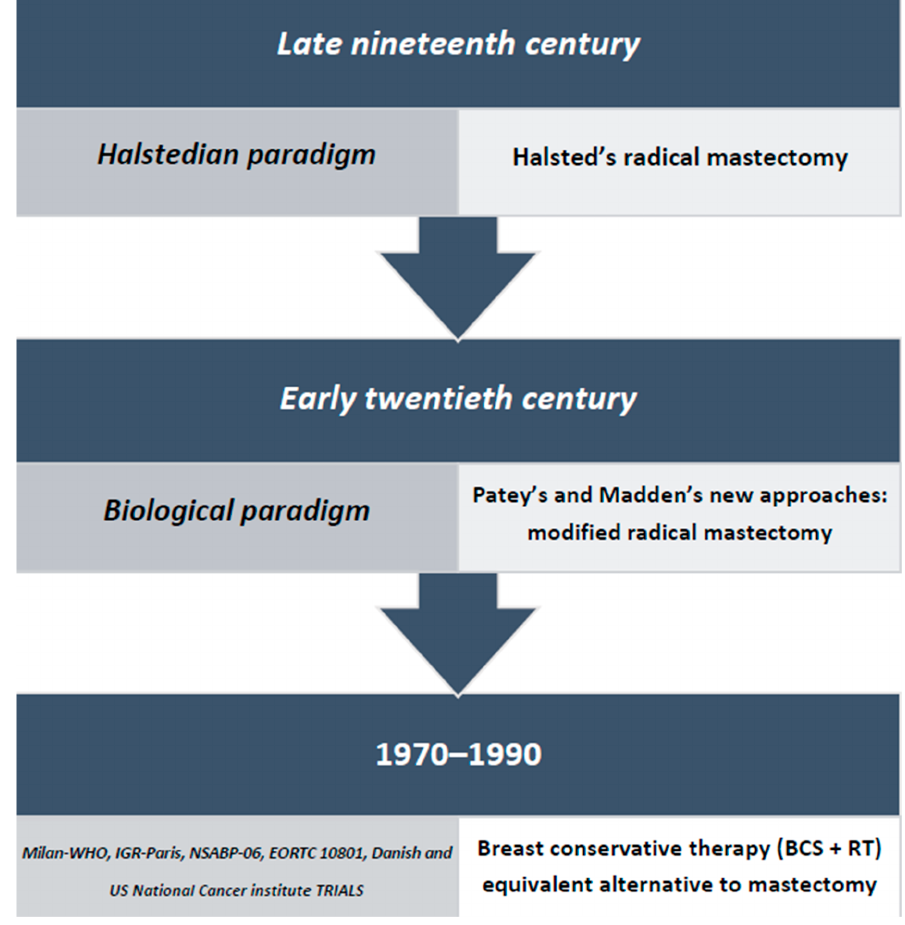
Figure 1. Evolution of breast cancer (BC)